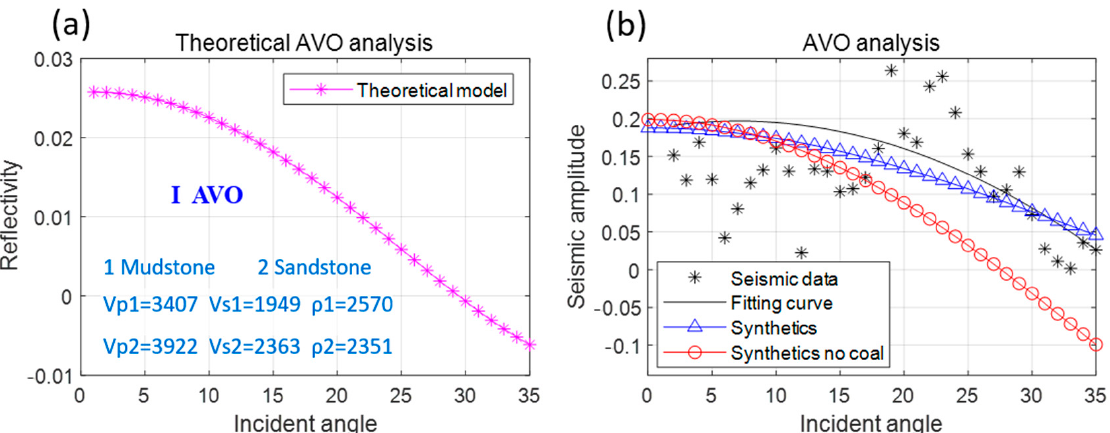
Figure 18. AVO response of the top interface of an oil-bearing sandstone: ( a ) Theoretical analysis; ( b ) AVO analysis.